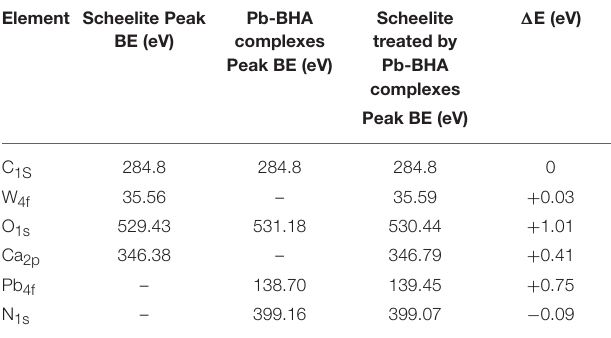
TABLE 2 | The peak binding energies on the scheelite surface before and after treatment with Pb-BHA complexes. Element Scheelite Peak BE